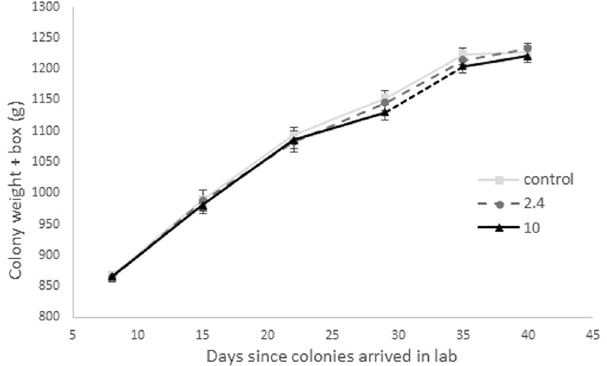
Figure 1. Bombus terrestris colony weight gain (g, including weight of outer box) over course of experiment from day 1 (2/4/2014) – day 40 (13/5/2014). N = eight colonies per treatment (24 colonies in total). Each colony was exposed to its respective treatment for a period of 26–27 days.